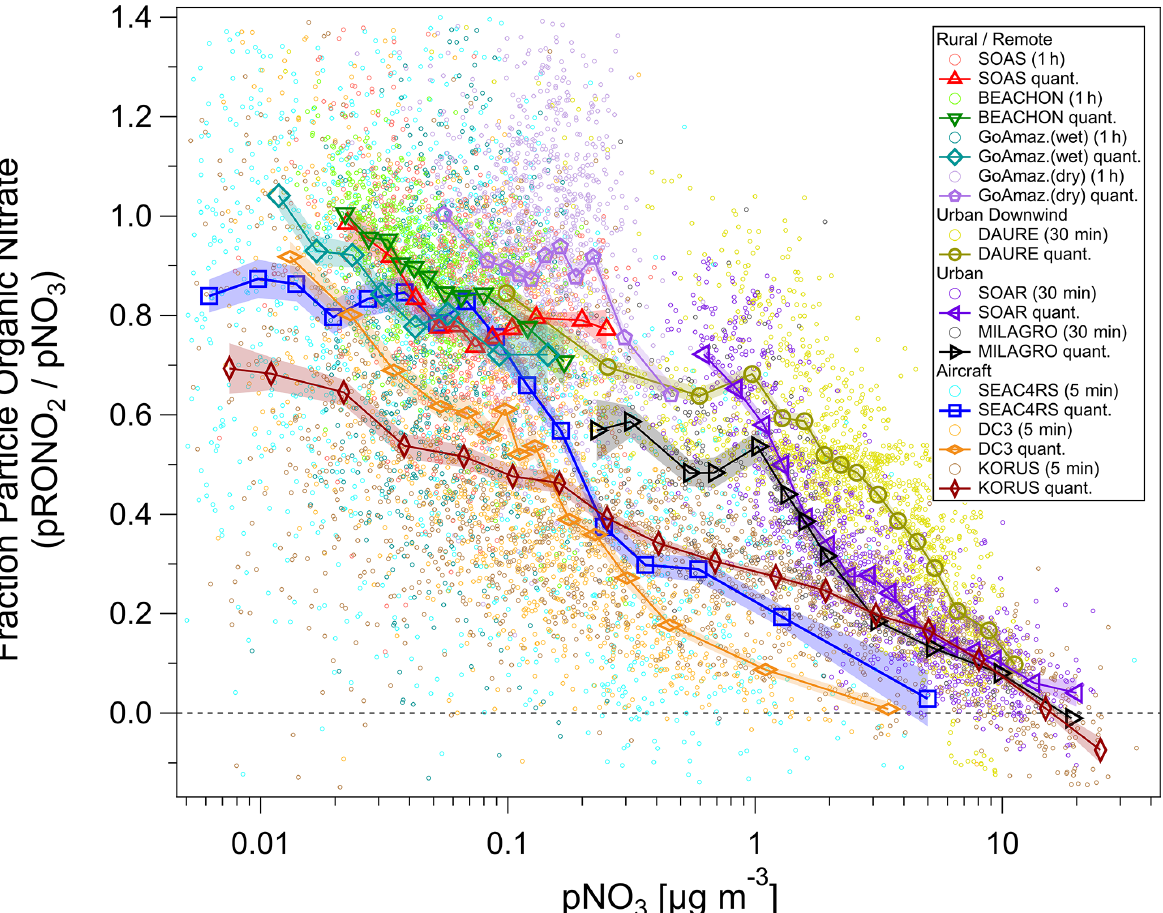
Figure 5. Fraction of total non-refractory submicron nitrate that is organic ( f pRONO ) vs. total nitrate concentration (pNO 3 ) for several 2 ground and aircraft campaigns. Campaigns span late winter to summer across the Northern Hemisphere and wet/dry seasons near the Equa- tor, from ground level to the upper troposphere, and urban to remote locations. NO + x ion signals were first averaged, and then data were conservatively screened for detection limits (signal-to-noise ratio > 1–3) using both NO + x ions (small circles). Quantile averages (means, 7–15bins) are also shown for each campaign. Additionally, for all campaigns, one additional average was calculated and included with the quantile averages for the highest 1% (3%) of pNO 3 for urban/aircraft (rural/remote) campaigns in order to extend the pNO 3 by a factor of ∼ 1.3–3 (undersampled chemical regime but with a sufficiently high signal-to-noise ratio). The average of the lowest 3% of pNO 3 for the MILAGRO campaign is also included. Shaded swaths indicate the standard error for the quantile averages. Many are no larger than the markers and thus may not be very apparent. See Fig. S31 for a simplified version, showing only binned averages and standard error